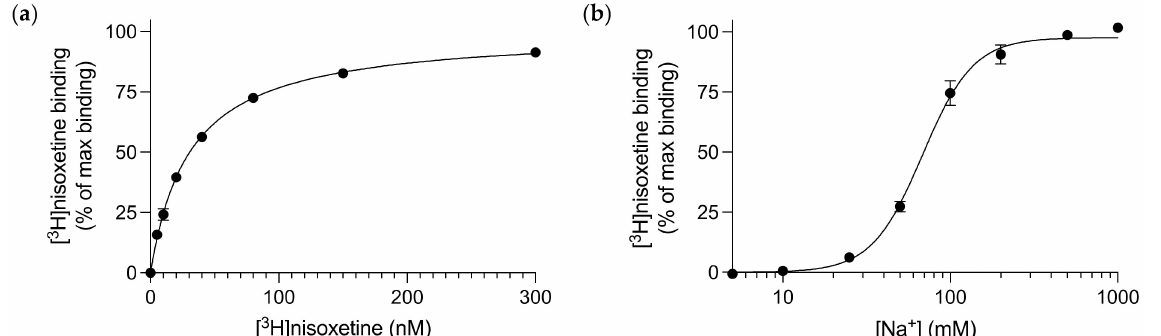
Figure 1. Characterizing [ 3 H]nisoxetine binding to purified dDAT. ( a ) Saturation binding of [ 3 H]nisoxetine to dDAT obtained a K d of 31 [28; 34] nM for nisoxetine. Data are shown as mean [SEM interval], n = 3 from 3 independent dDAT purifications performed in triplicates and data are fitted as a one-site specific binding curve. ( b ) Na + -dependent [ 3 H]nisoxetine binding to dDAT. The EC 50 value for Na + binding to dDAT in the presence of 120 nM [ 3 H]nisoxetine was 68 [65; 71] mM. Ionic concentration is kept constant by substitution of Na + with NMDG + . All data points represent mean ± SEM, n = 3 from at least 2 independent dDAT purifications performed in